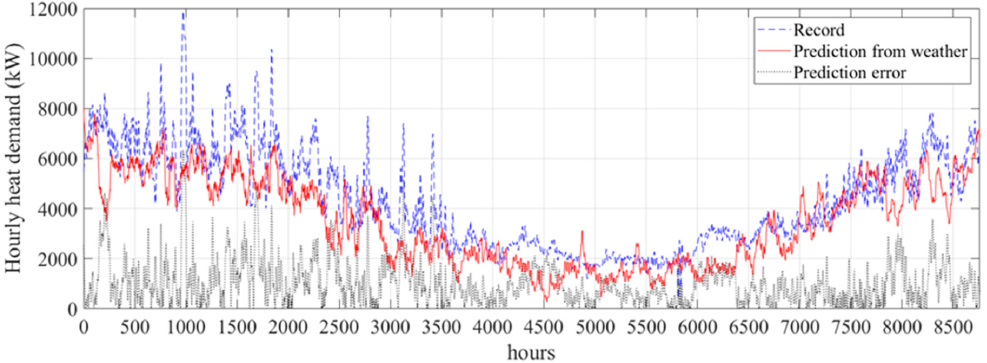
Figure 11. Comparison between record and predicted hourly heat demand .